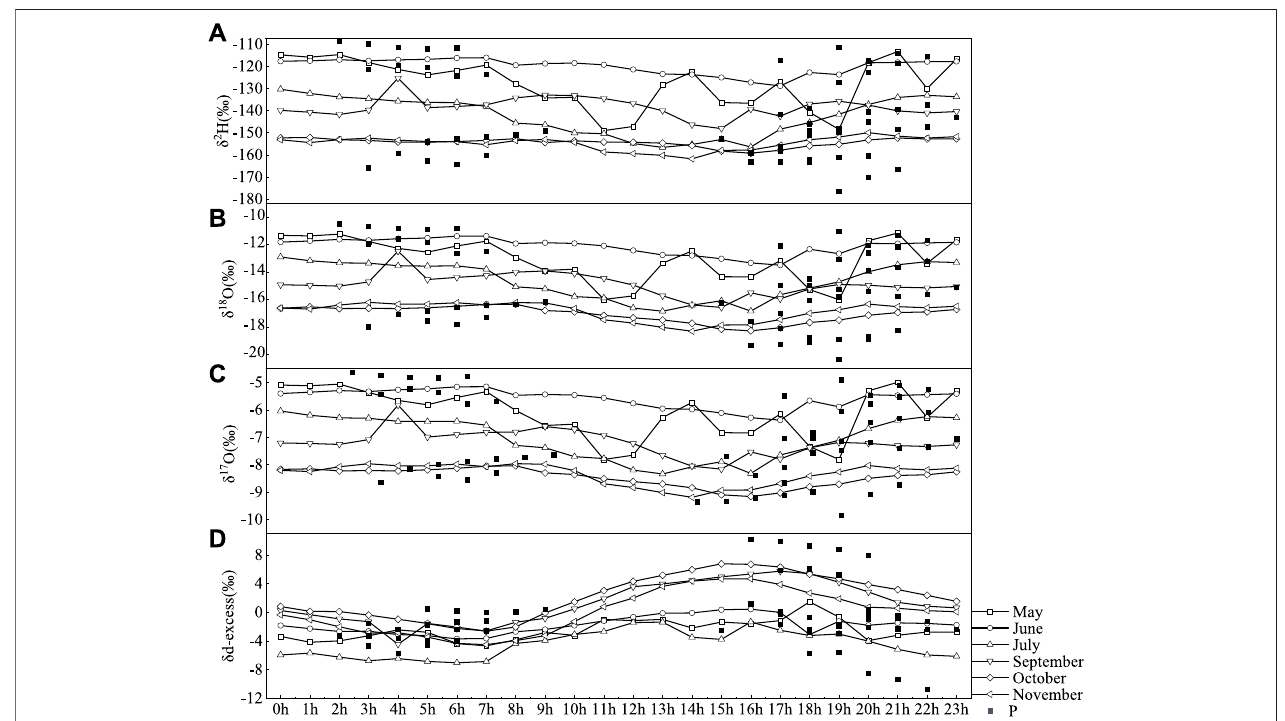
FIGURE4| Hourlyvaluesof δ 2 H (A) , δ 18 O (B) , δ 17 O (C) ,andd-excess (D) oftheatmosphericwatervaporandprecipitation(squares)fromMaytoNovember2019 in Lanzhou, China, and 76.3 ‰ , respectively. The minimum δ 2 H and δ 18 O values occurred in the afternoon (1400 – 1800 CST, Chinese standard time), and the δ 2 H and δ 18 O maximums appeared at midnight. These diurnal variations appeared to be in phase with the vapor mixing ratio variations (Welp et al.,